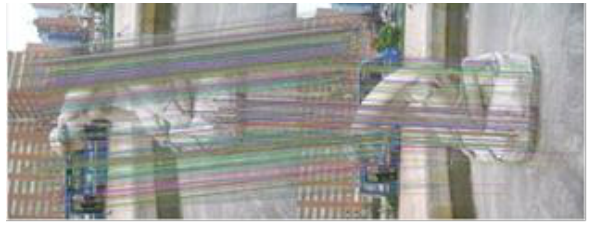
Figure 13. Common points among the images.